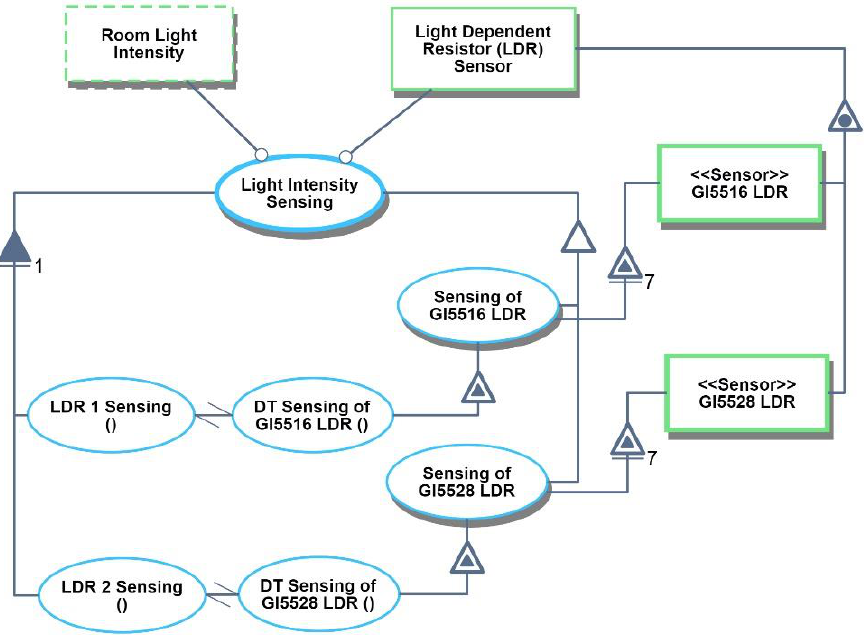
Figure 19. The Sensing processes connected to their corresponding Sensing stereotype processes.